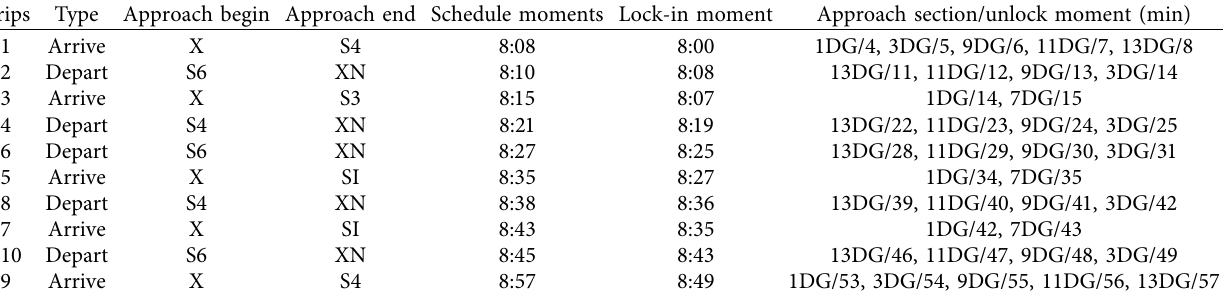
Table 1: Train approach sequence from 8:00-9:00 at Station A.